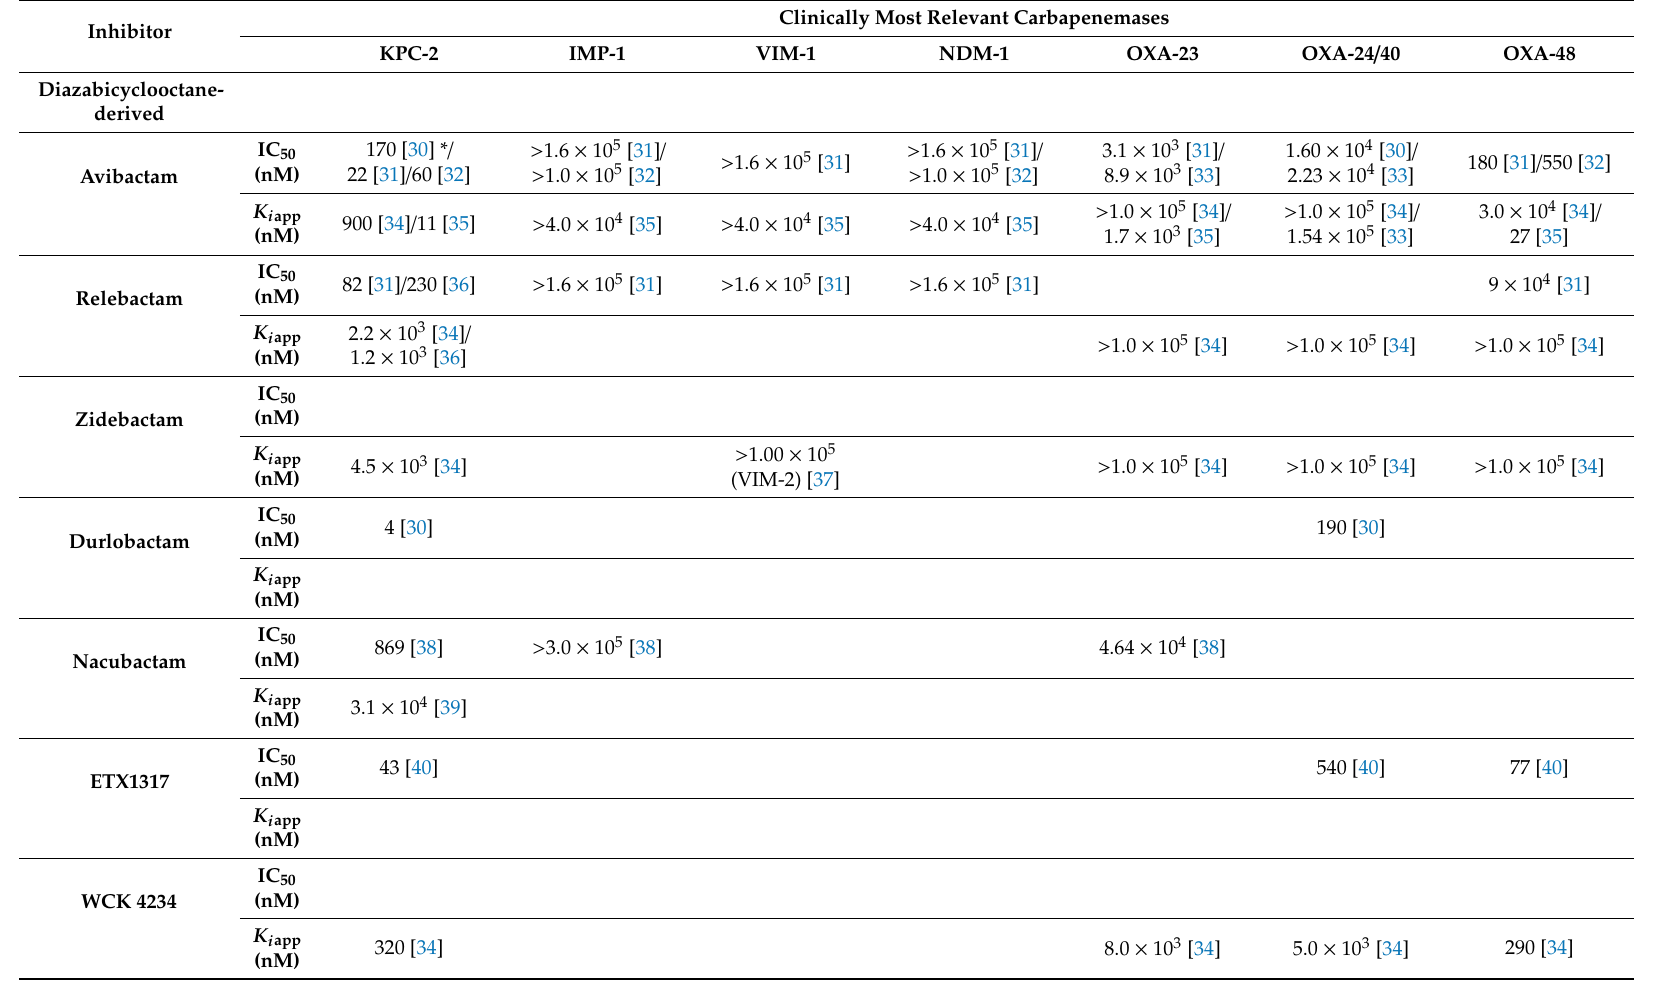
Table 3. Kinetic parameters of compounds tested against main